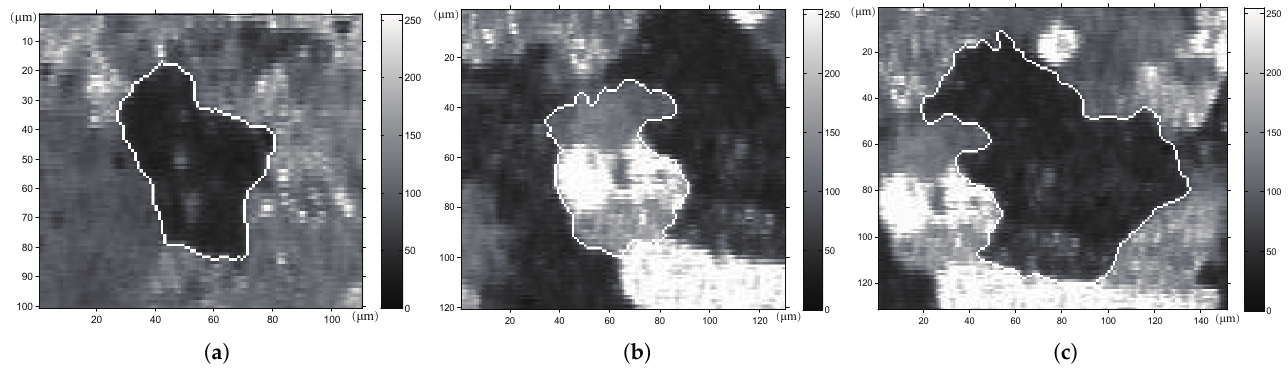
Figure 4. The boundary diagram of three grains in GRAB1: ( a ) grain 1; ( b ) grain 2; ( c ) grain